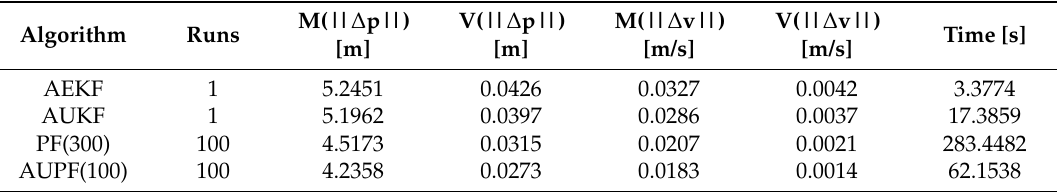
Table 2. Performance comparison between state-of-the-art